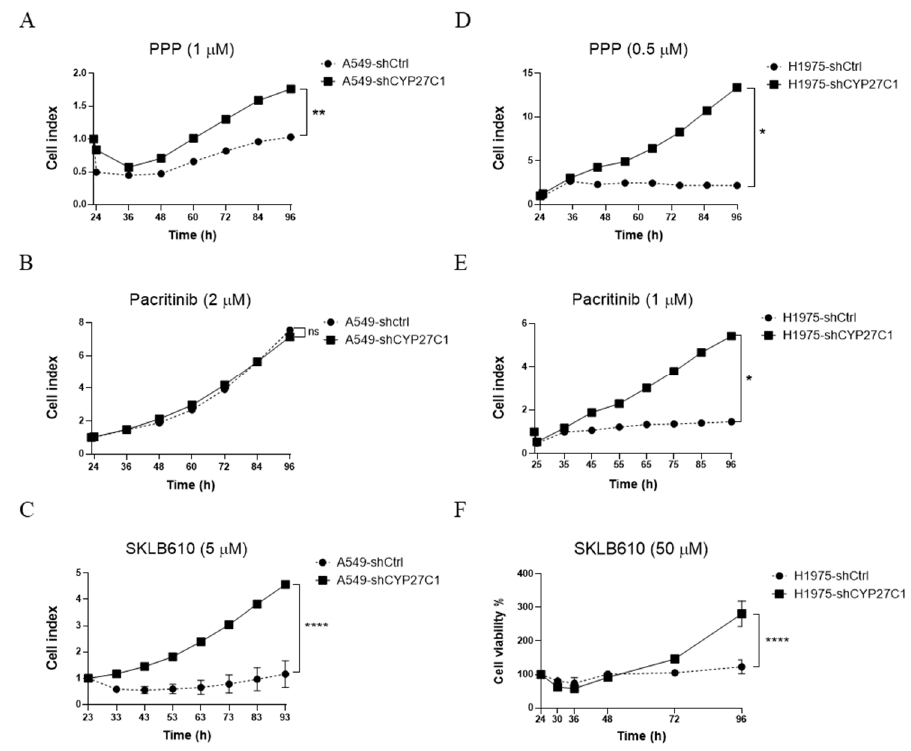
Figure 8. CYP27C1-knockdown attenuates anticancer potency of protein kinase inhibitors. ( A – E ) A549-shCYP27C1, H1975-shCYP27C1, and the corresponding control cells were treated with indicated concentration of protein kinase inhibitors (picropodophyllin, pacritinib, and SKLB610). Real-time cell index reflecting cell viability were detected by RTCA-S16 System. Results were analyzed by two-way ANOVA. ****, p <0.0001, **, p <0.01, *, p < 0.05, n.s., p > 0.05. ( F ) Stable CYP27C1-knockdown H1975 cells and the corresponding control cells were treated with indicated concentrations of SKLB610, cell viability was determined by MTS assay at different time point, and analyzed by two-way ANOVA. ****, p